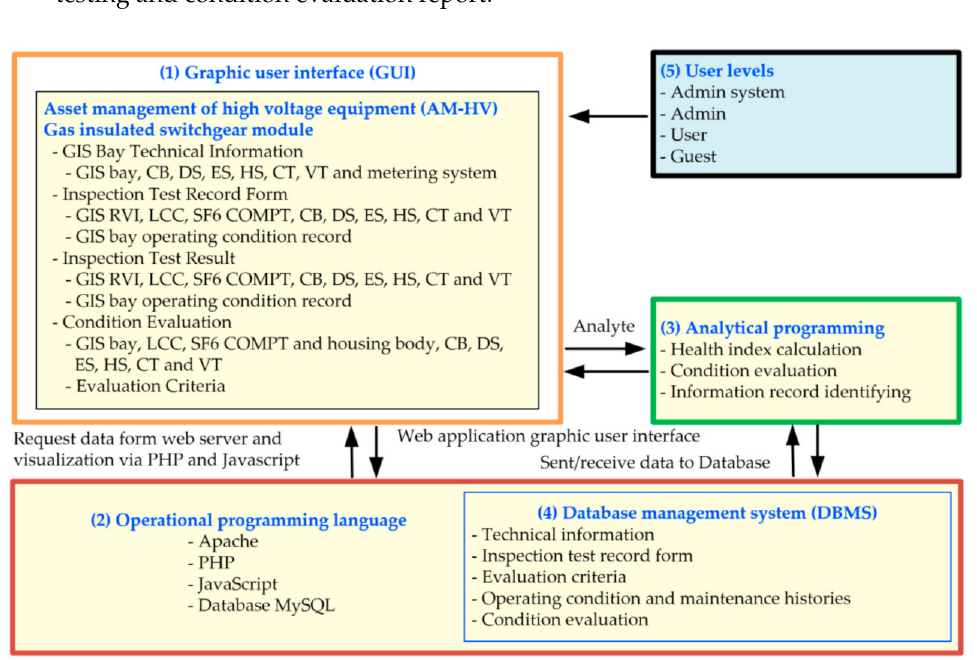
Figure 2. Web application architecture and database management